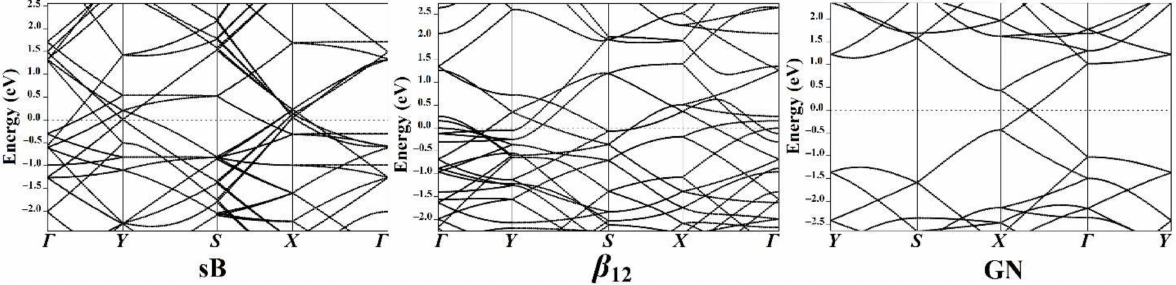
Figure 5. Band structure plots for the pure surfaces of sB, β 12 , and GN along the high-symmetry points of the Brillouin zone. The Fermi energy is set to zero-energy.